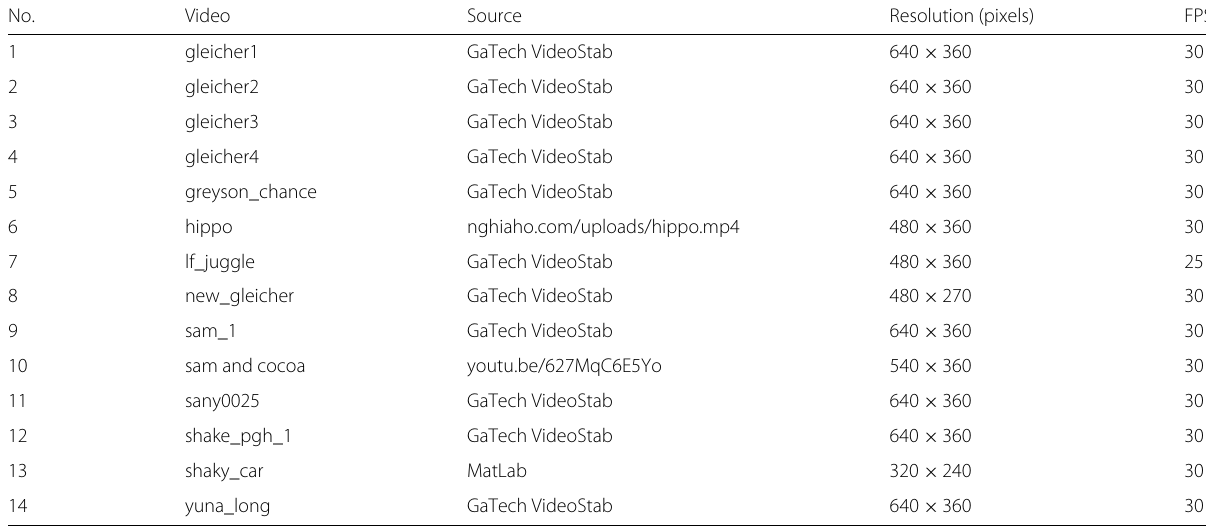
Table 1 Video sequences used in our experiments No.